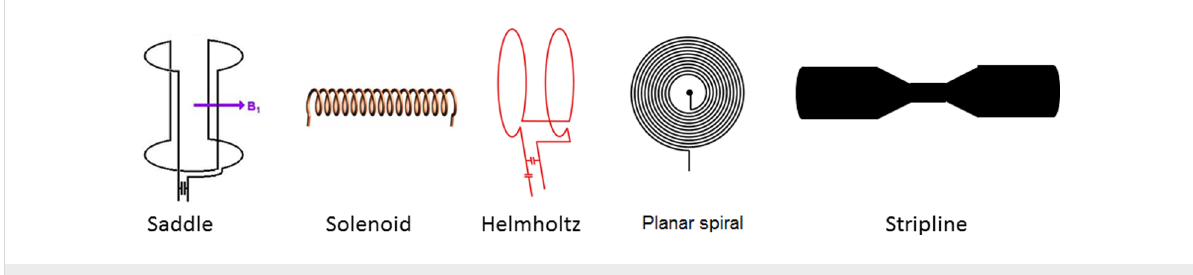
Figure 2: Possible geometries of NMR